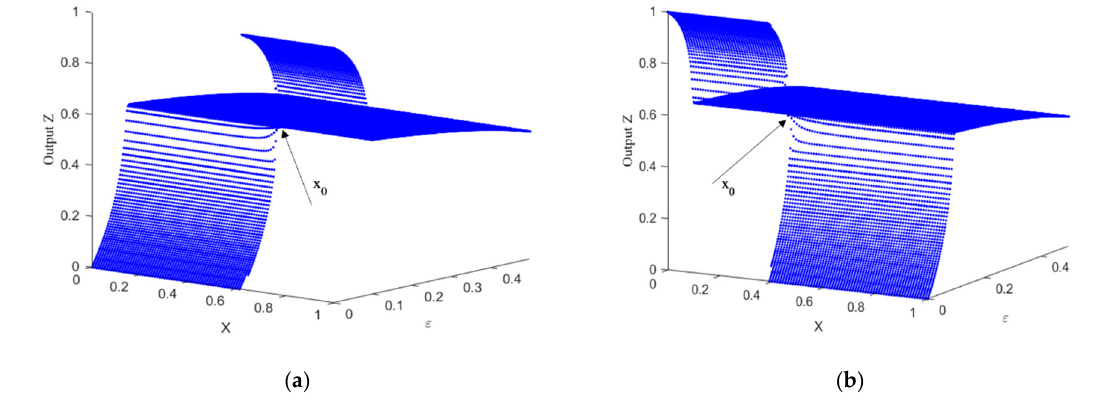
Figure 9. 3-D diagrams of XOR multiplexing for fixed input Y: ( a ) fixed 0 Y = ; ( b ) fixed 1 Y = .